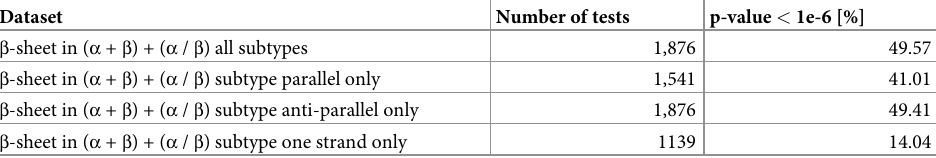
Table 4. Results of the Kolmogorov-Smirnov test applied to β -sheets in the ( α + β ) + ( α / β ) protein dataset. Dataset